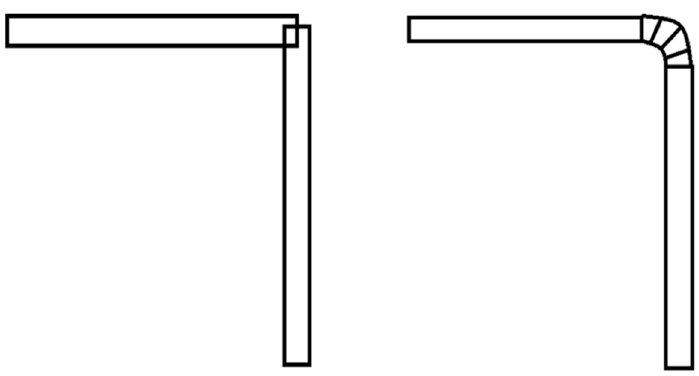
Figure 2. Construction of smooth tube.